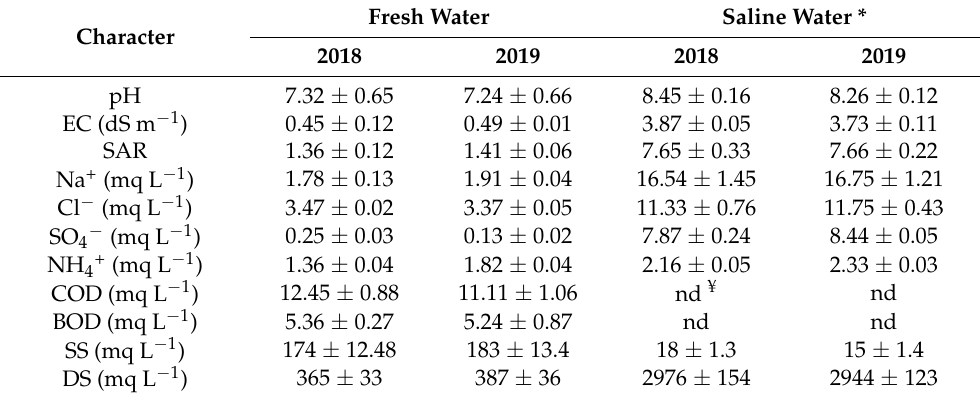
Table 7. Characterization of irrigation water during the 2019/2020 and 2020/2021 growing